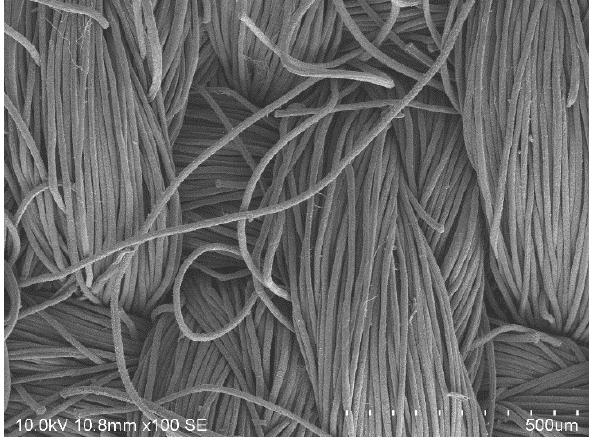
Figure 11. SEM micrograph of amorphous m-aramid fibers dyed with Nigrosin in EMIM-EtSO 4 at 180 °C.